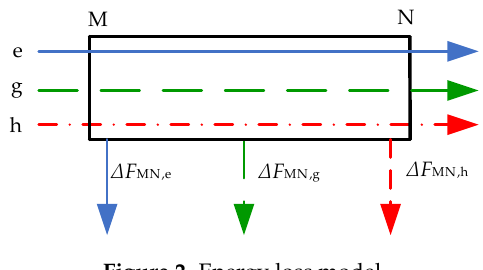
Figure 2. Energy loss model.